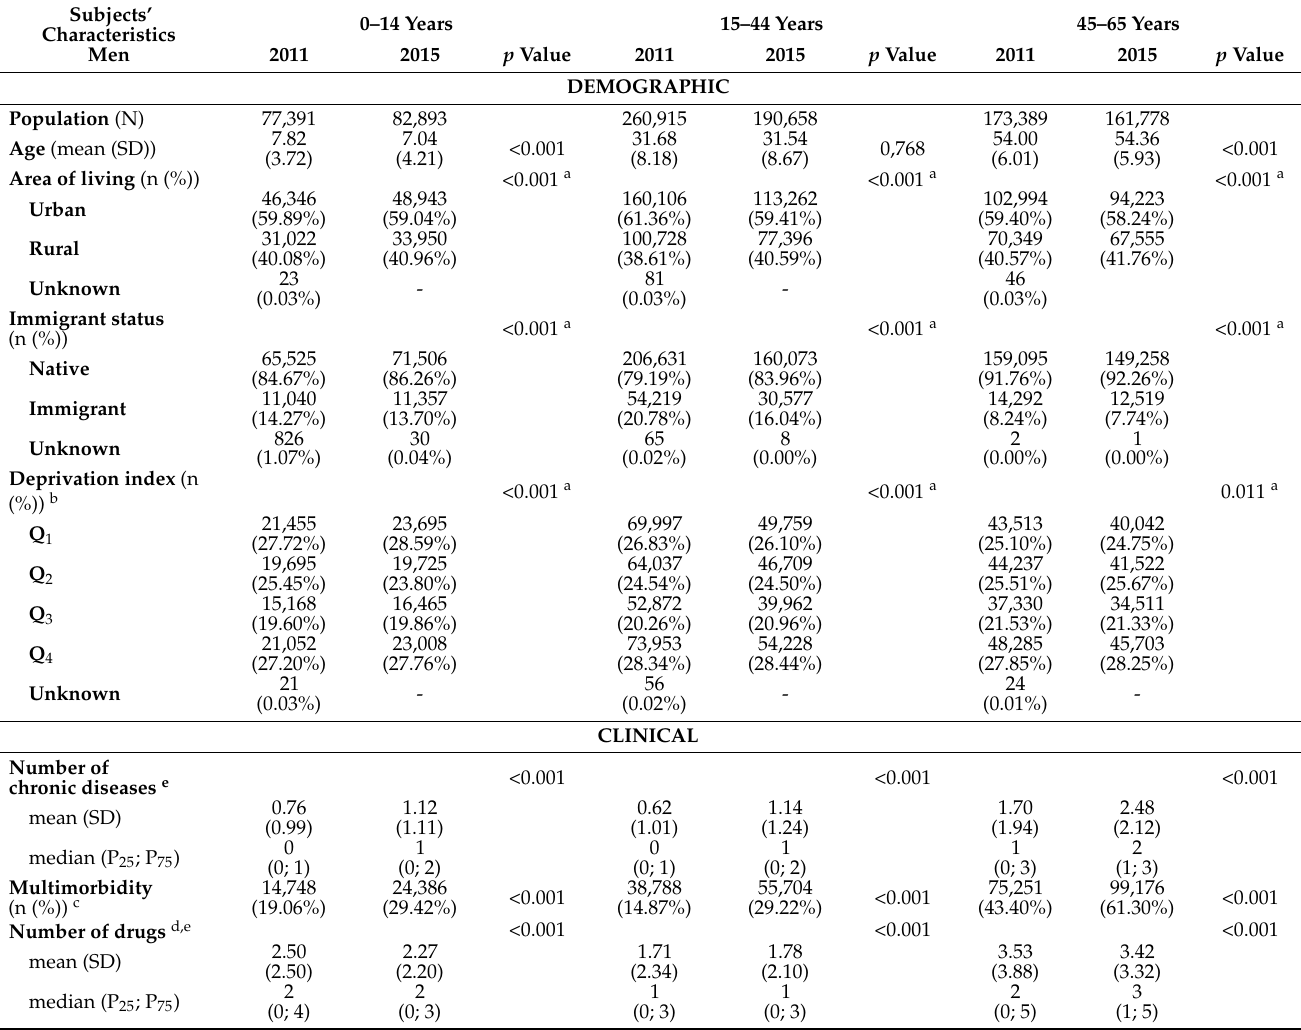
Table 2. Demographic and clinical characteristics of men in 2011 and 2015.